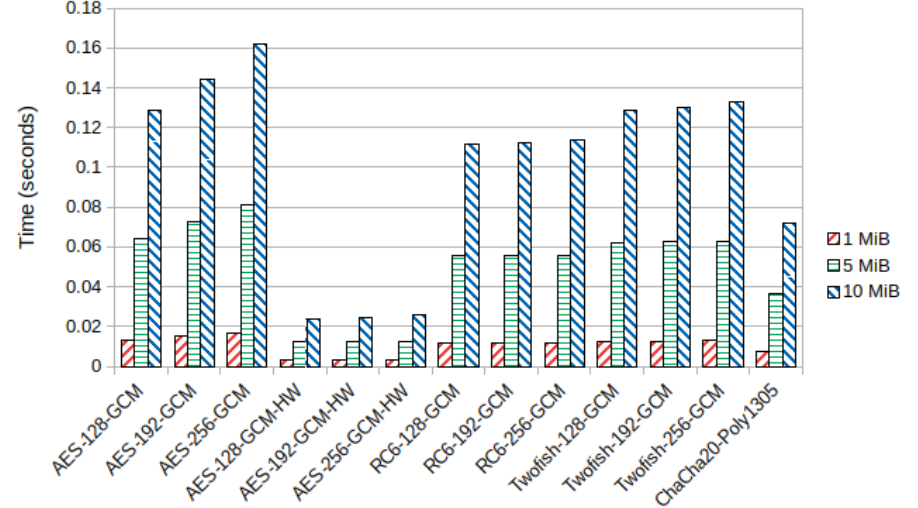
Figure 6. Average encryption time (seconds) in the ARMv8-a Xiaomi device.